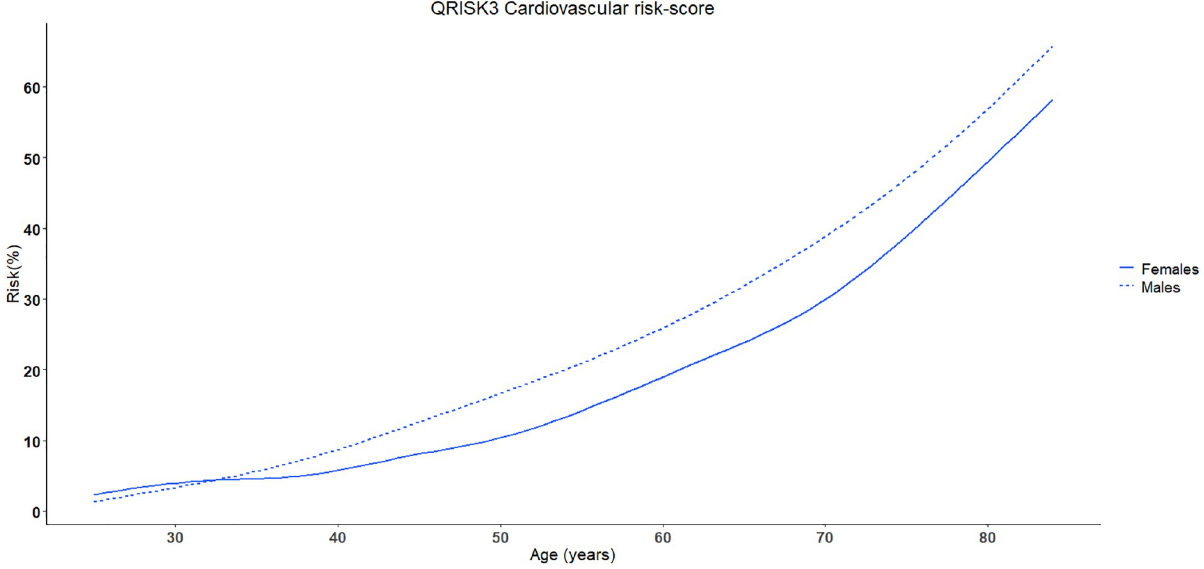
Fig 1. Cardiovascular risk based on QRISK3 chart related to age and separated for sex.